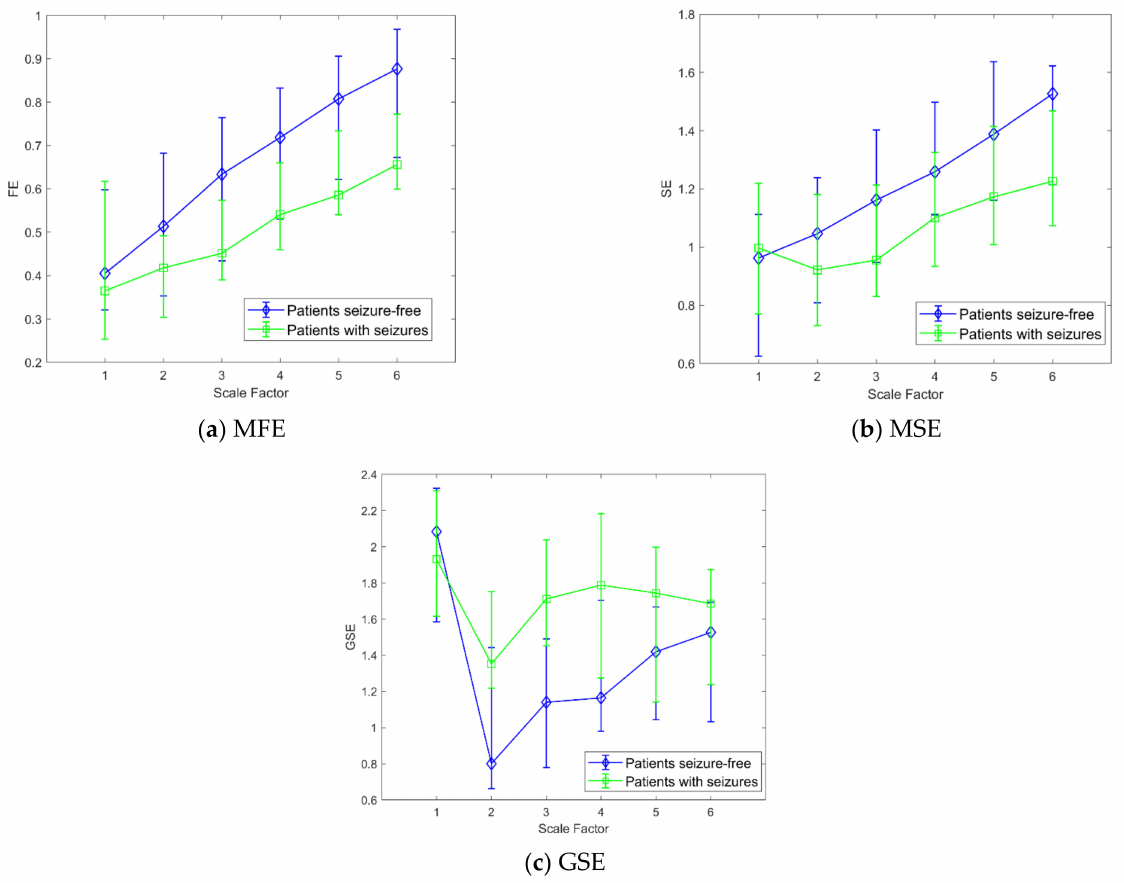
Figure 6. MFE ( a ), MSE ( b ), and GSE ( c ) trends considering all the windows for the patients with seizures ( (cid:3) markers) compared to the seizure-free patients ( ♦ markers). The values at each scale represent the median and IQR among patients.